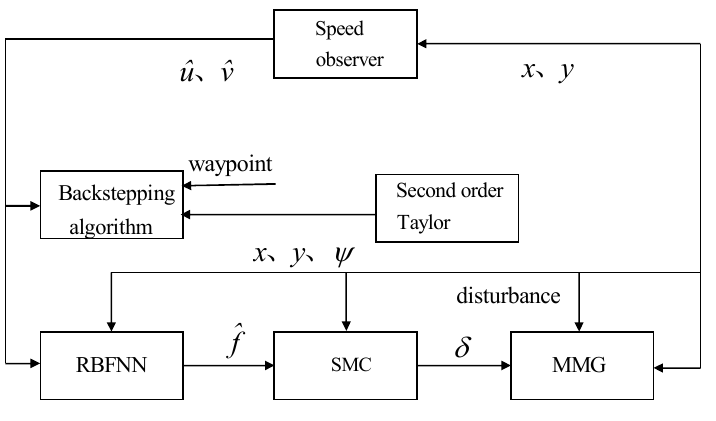
Figure 2. Whole control structure.